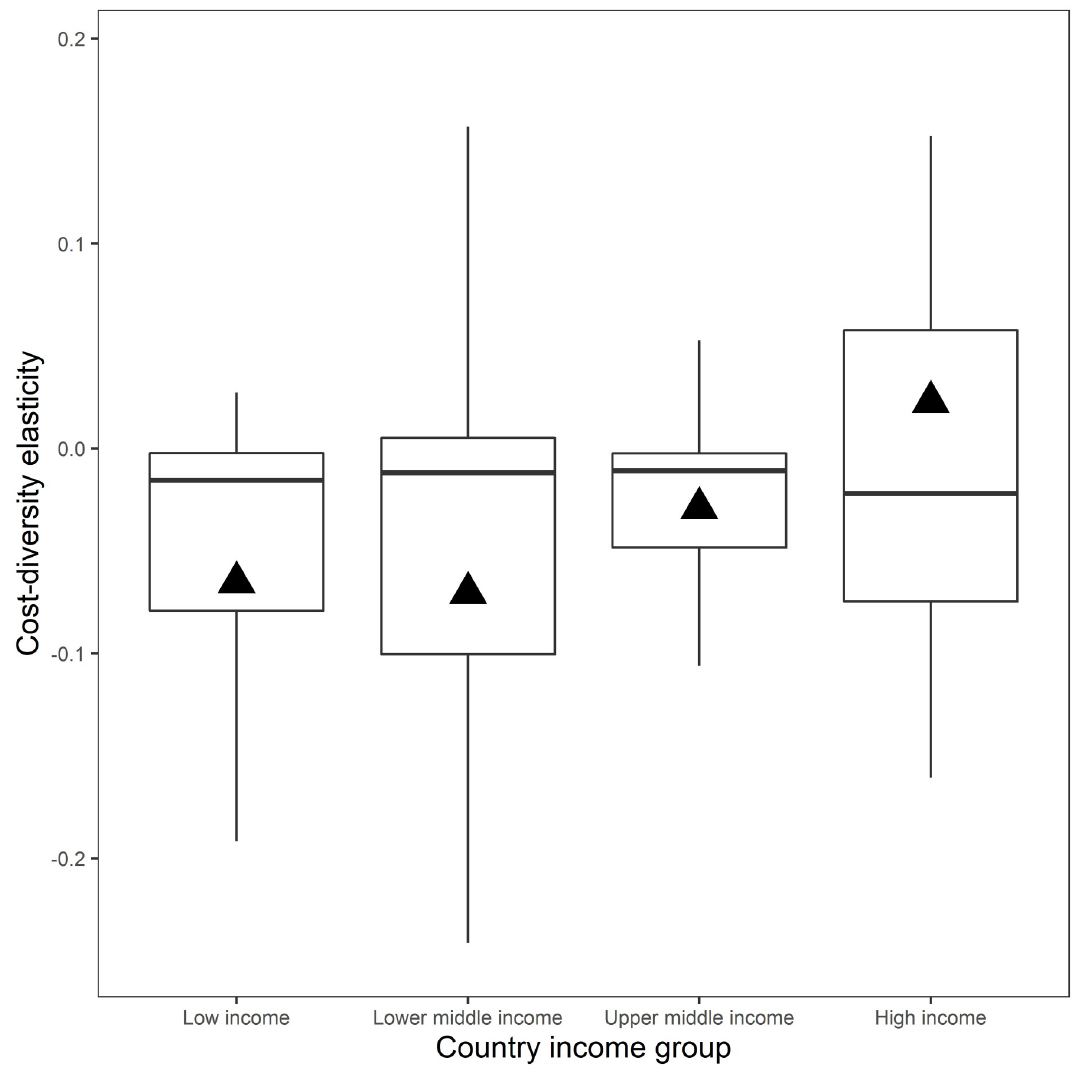
Fig 2. Cost-diversity elasticity around diversity level in the cereal grain reference ration. The cost-diversity elasticity is the percentage change in ration cost in response to a one percent change in the Simpson Index of diversity. Reference rations complied using a global dataset [5] . Data reported based on simulations using reference prices in Table 3 . Boxes indicate the interquartile range (IQR). The upper whisker extends from the third quartile upper hinge of the box to the largest value no further than 1.5 × IQR from the upper hinge. The lower whisker extends from the first quartile lower hinge of the box to the smallest value at most 1.5 × IQR from the lower hinge. The line dividing each box shows the median. Triangle markers show the